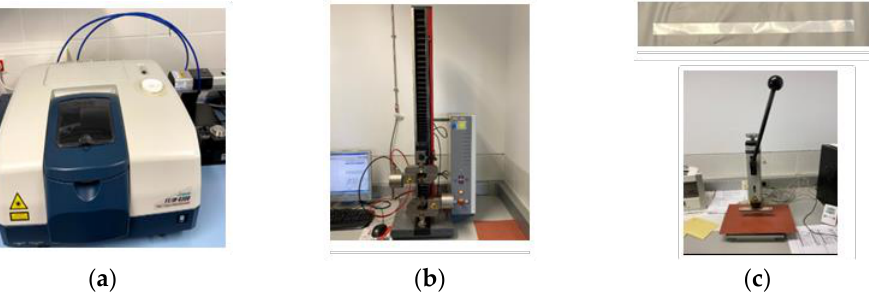
Figure 6. ( a ) Jasco FT-IR 6300; ( b ) ZwickRoell BZ1-MMZ2.5.ZW01; ( c ) 1 × 15 cm specimen and press.